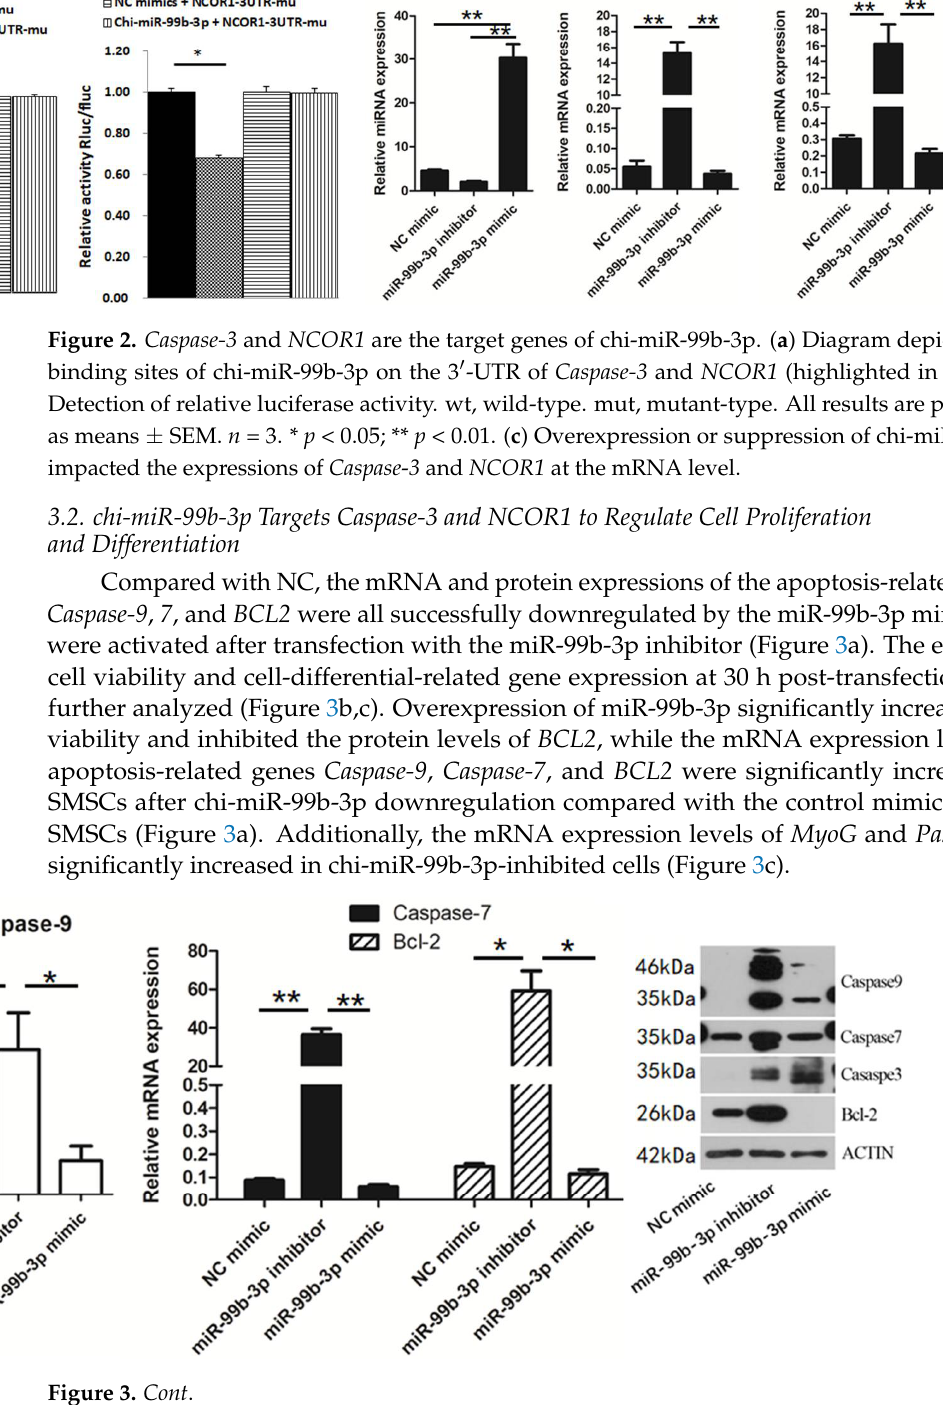
Figure 3. chi-miR-99b-3p regulates cell proliferation and differentiation via the intrinsic apoptotic pathway. ( a ) mRNA and protein levels of apoptosis-related genes after transfection with chi-miR- 99b-3p mimic or inhibitor. ( b ) Cell counts detected by CCK-8 analysis. ( c ) mRNA levels of differen- tiation-related genes after transfection with chi-miR-99b-3p mimic or inhibitor. Original Figure 3a in Figure S2. 3.3. mRNA Profile Analysis after Upregulation of chi-miR-99b-3p Using mRNA sequencing analysis, 1490 DE genes were obtained |log2 fold change |≥1 and Q value ≤ 0.001 in miR-99b-3p mimic-transfected cells compared with the NC miRNA-treated cells (Figure 4a). Further functional analysis of these DE genes showed that after overexpression of chi-miR-99b-3p, the DEGs in the skeletal muscle cells were mainly involved in the cell cycle, relaxin signaling pathway, DNA replication, and protein digestion and absorption (Figure 4b), demonstrating that chi-miR-99b-3p was mainly in- volved in cell cycle regulation. In addition, the DE genes associated with the cell cycle process are listed in Table S4. Most of the cell-cycle-related genes were downregulated in SMSCs after chi-miR-99b-3p upregulation; among them, the pro-apoptosis-related gene BCL2 , which is demonstrated to be downregulated in Figure 3a , was decreased in chi- miR-99b-3p upregulated cells based on sequencing data. However, we did not see down- regulation of Caspase-3 or NCOR1 in the SMSCs after chi-miR-99b-3p upregulation, based on the filter condition of |log2 fold change | ≥ 1 and Q value ≤ 0.001. In addition, we also found 34 genes, including SH2D4A , ABCB10 , B3GNT6 , OPCML , and SPATA13 , predicted to be candidate targets of chi-miR-99b-3p, which were downregulated in the cells after miR-99b-3p upregulation (Table S5). 3.4. miRNA Profile Analysis after chi-miR-99b-3p Upregulation To evaluate the potential miRNAs influenced by chi-miR-99b-3p upregulation, small RNA-sequencing analysis was performed, and the DE miRNAs are shown in Table S6.